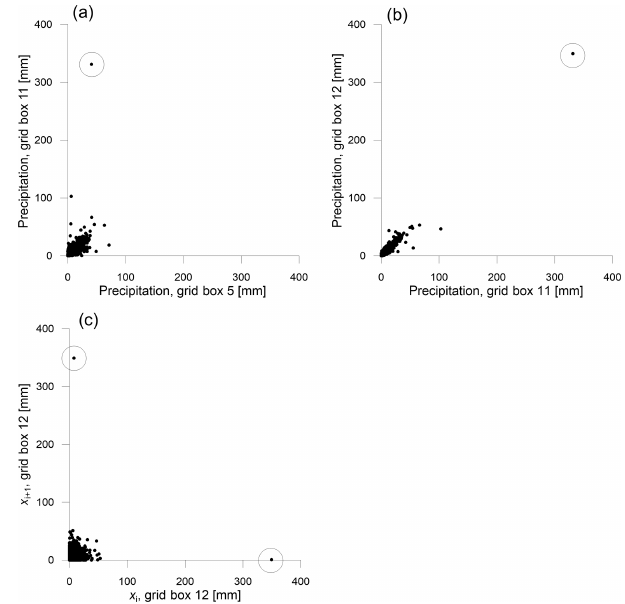
Figure 6. The effect of outliers on correlation structures of model 2A in the future period (the outliers are circled): (a) the outlier strongly affecting the cross-correlation, (b) the outlier with no ef- fect on the correlation, (c) the outlier affecting the calculation of the serial correlation r 1 12